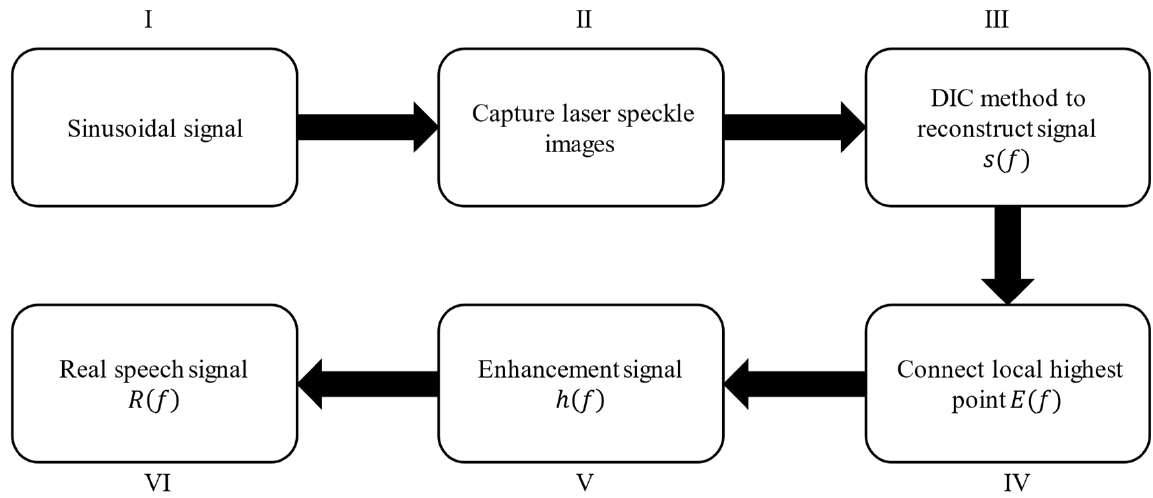
Figure 6. Speech enhancement algorithm.